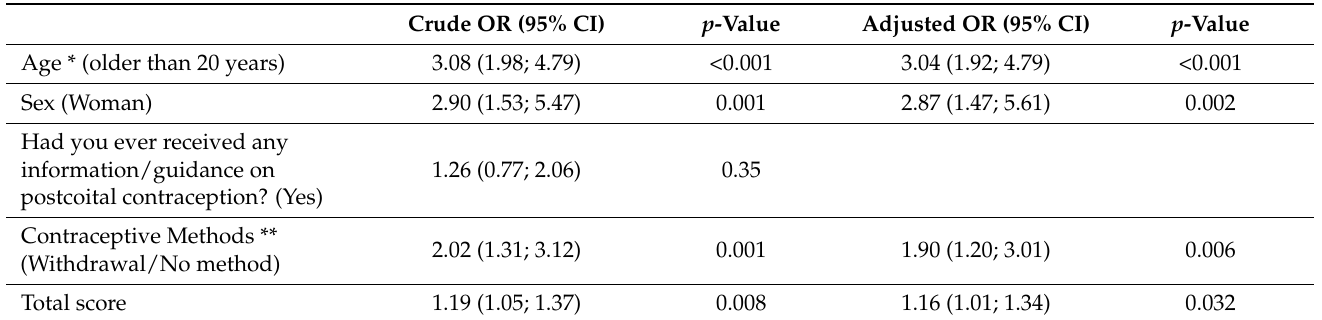
Table 3. Risk factors associated to ECP use. Crude OR (95% CI) p